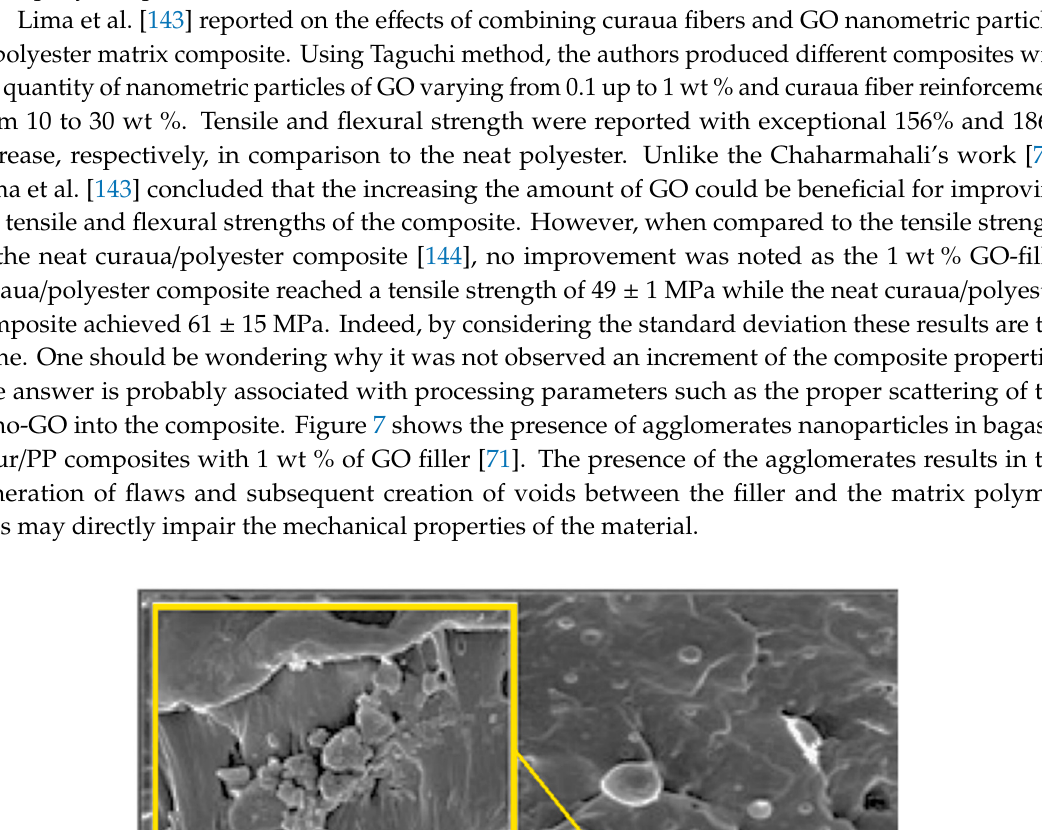
Figure 6. SEM microphotographs of: ( a ) pristine GNP; ( b ) composite filled with 5 wt % GNP showing agglomerated GNPs. Adapted from [73].